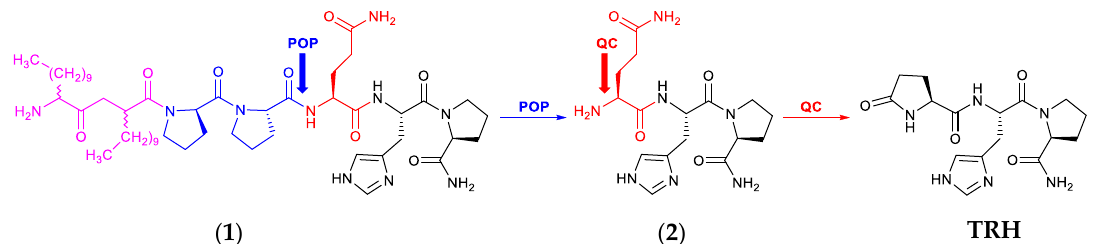
Scheme 1. Schematic illustration of the bioactivation of the prototype prodrug ( 1 ) to TRH in the brain. The LAA moiety (magenta) with the POP-sensitive linker (blue) is removed by POP liberating